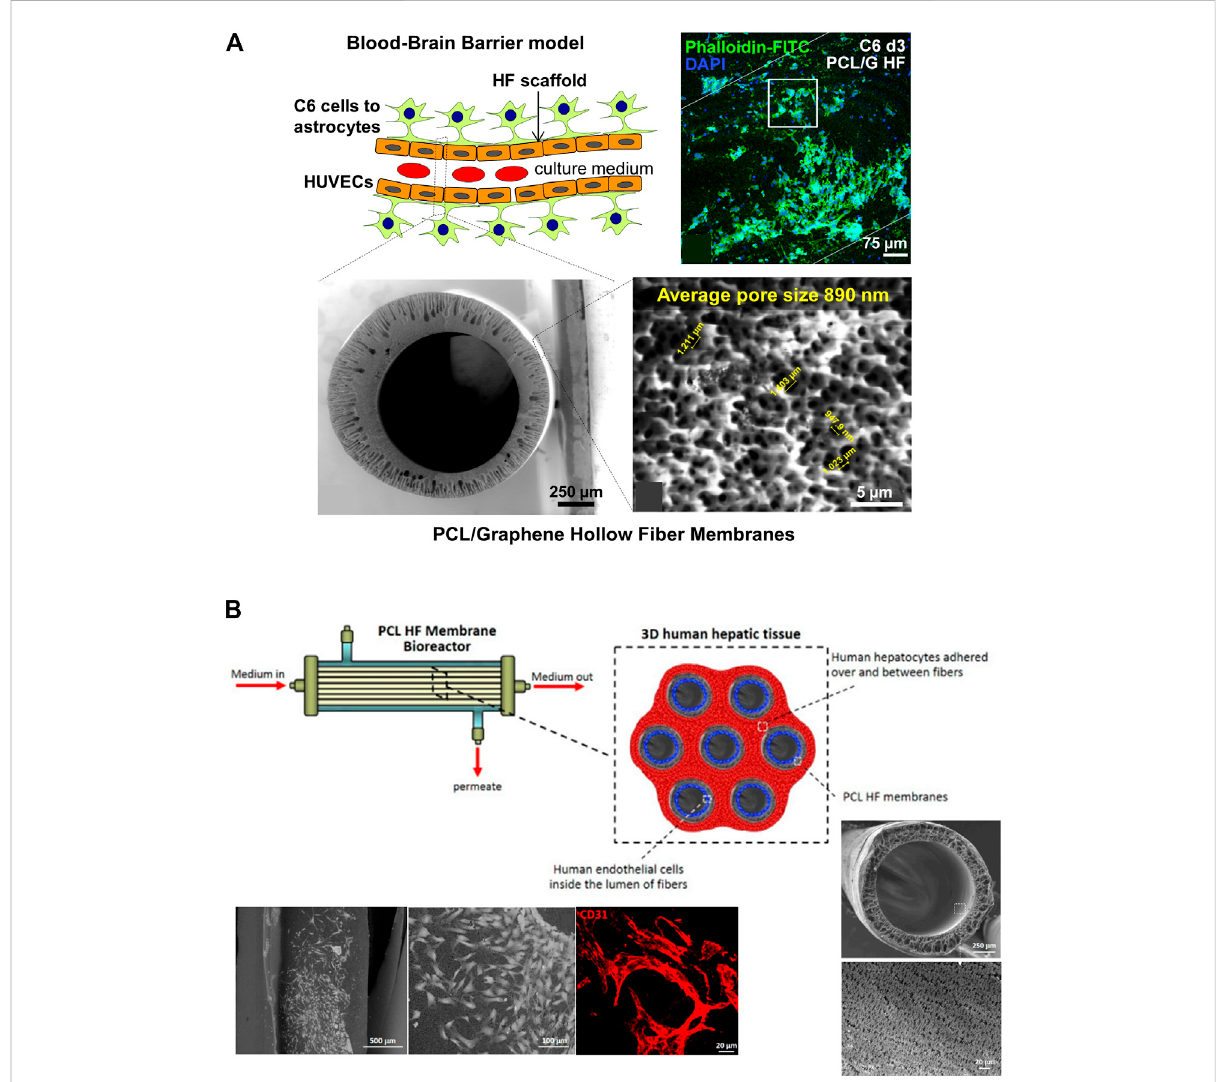
FIGURE 7 (A) Schematic representation ofan idealBBBmodel considering thedifferentiation ofC6 cellstowardsastrocytes intheoutersurfaceoftheHF and the seeding of HUVECs inthe lumen. The schemedepicted the cross-sectionand outersurface ESEM imagesof the PCL/G HFswith an average surfaceporesizeof0.89 µm.Therepresentativeconfocalimageshowsthestudyofastrocytedifferentiationfor72 honPCL/Gscaffoldswherecells reduced their nuclear size and presented numerous cytoplasmic projections (Mantecón-Oria et al., 2020). (B) Scheme of a 3D human hepatic tissue model in a HF perfusion bioreactor by culturing human hepatocytes over and between a bundle of seven PCL HFs, and endothelial cells cultured inthelumen oftheHFs. Scanning electronmicroscopy (SEM)imagesshow thecross-sectionand lumensurfaceofthePCL HFmembranes aswellastheHUVECcellsculturedinthelumenoftheHFsafter18days.TheconfocalimageshowstheHUVECdifferentiationinelongatedcellsand tube- and ring-like structures resembling capillary features, and expressing the CD31 in red (Salerno et al.,